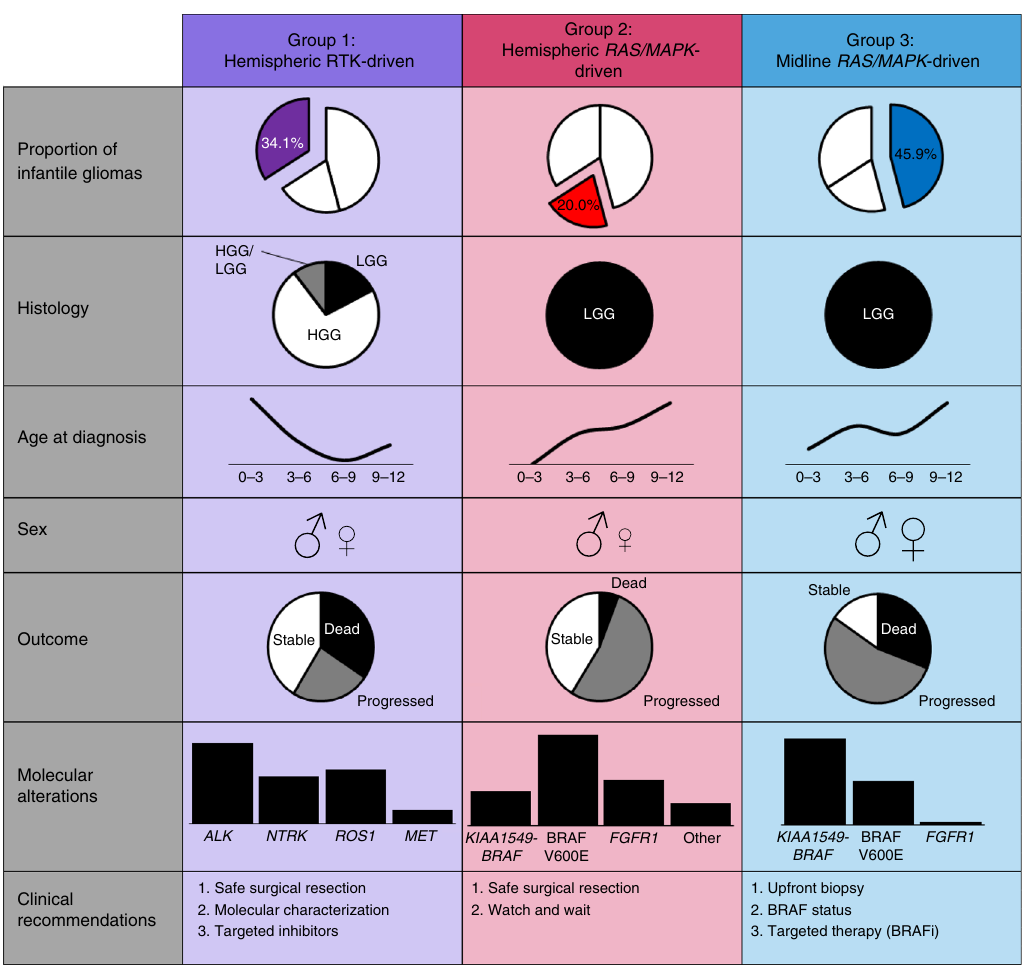
Fig. 6 Graphical summary of the three infant glioma subgroups. HGG: high-grade glioma, LGG: low-grade